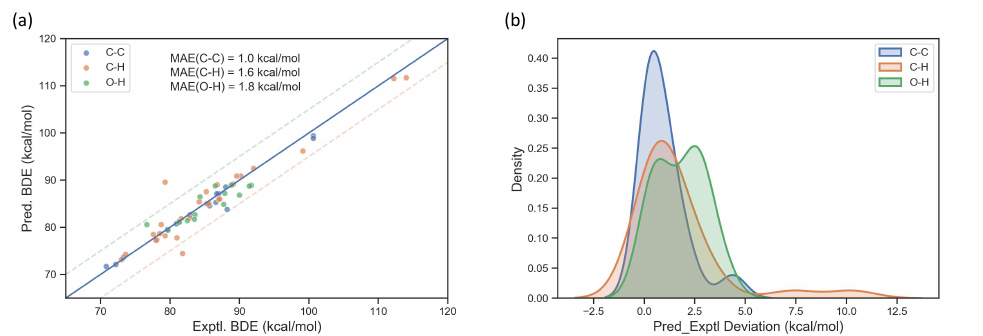
Figure 6. ( a ) Comparison between the predicted and experimental BDEs for the 217 C-C, 375 C-H and 141 O-H bonds contained in our test set. ( b ) Distribution of errors between the predicted and experimental